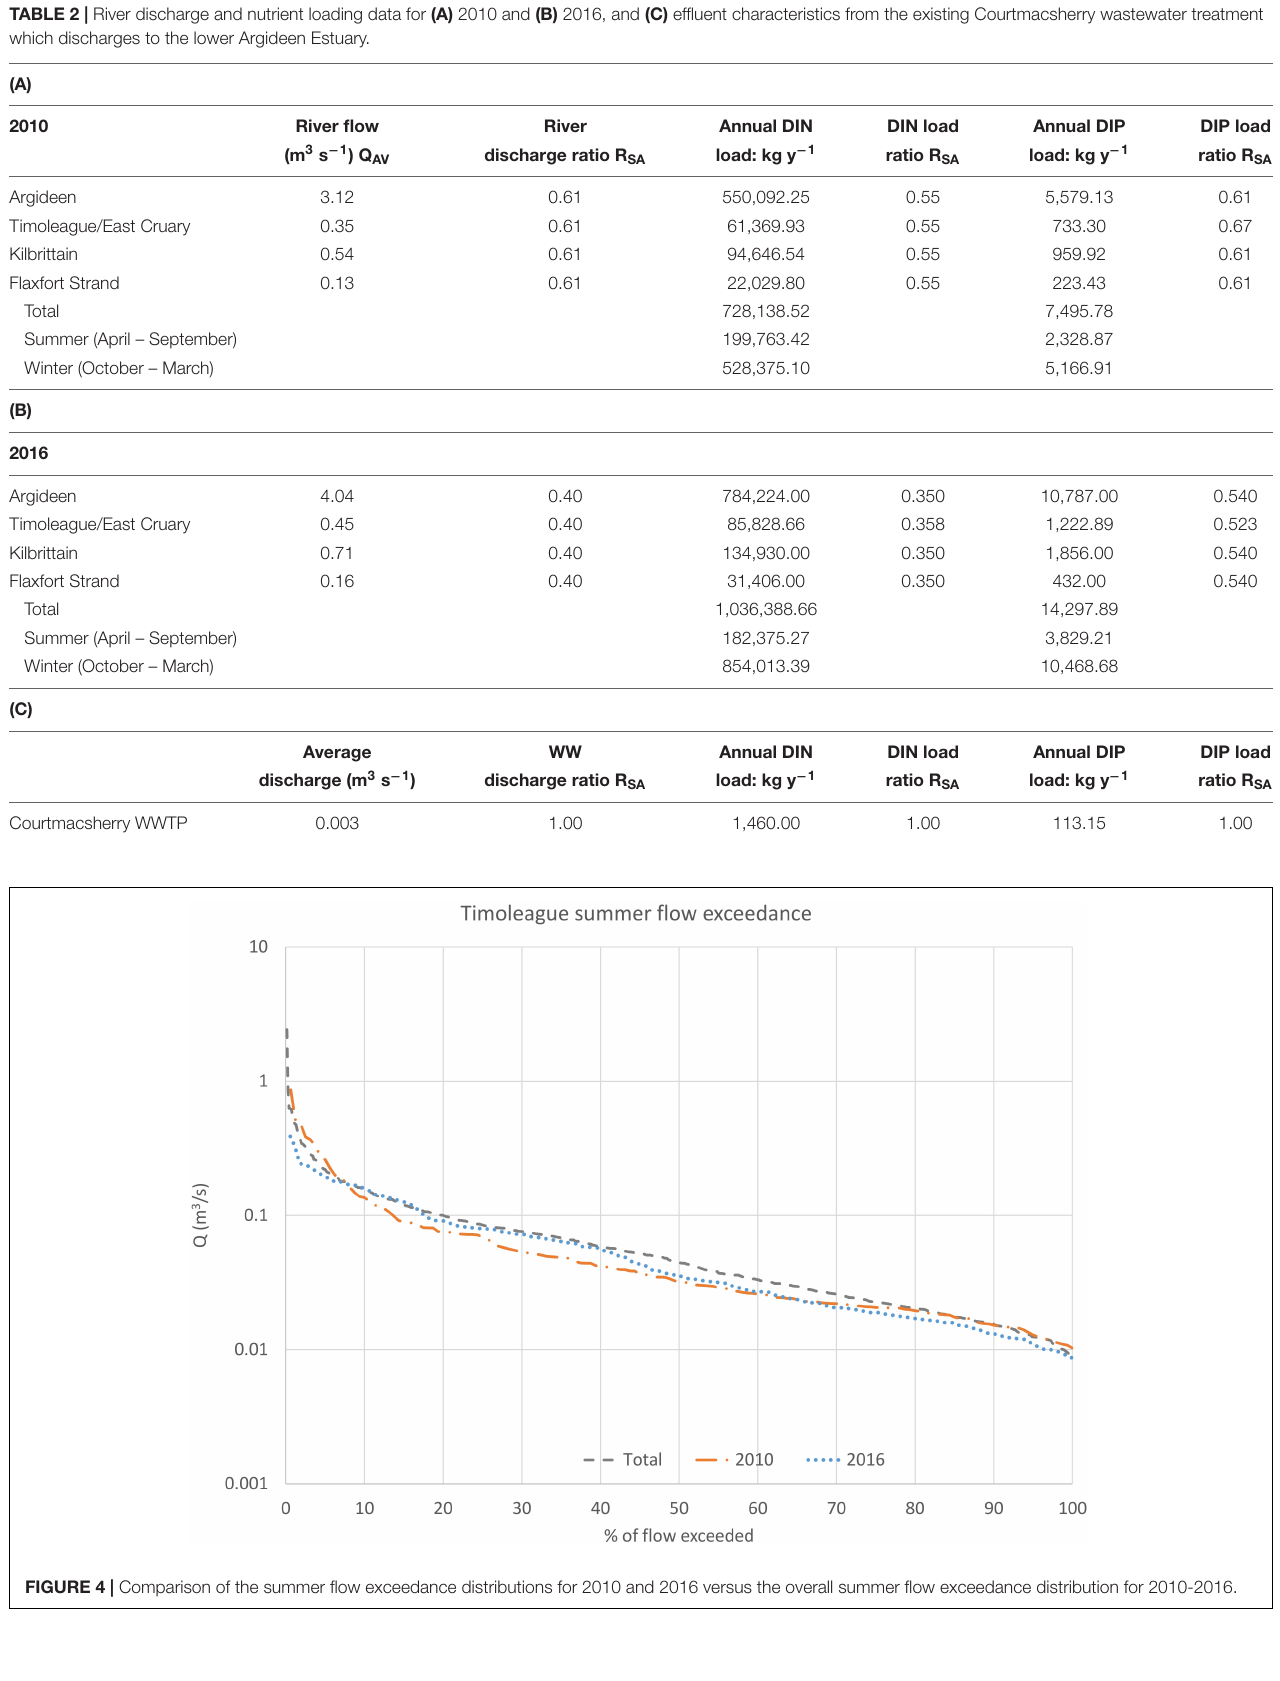
Frontiers in Marine Science |